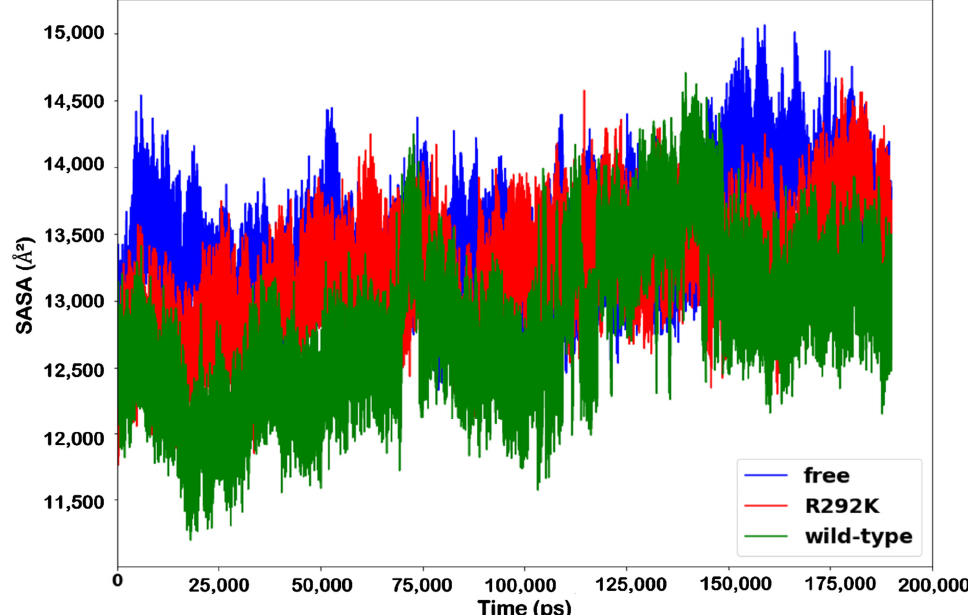
Figure 8. SASA (Å 2 ) plot of peramivir-free neuraminidase and the peramivir-wild-type and peramivir- R292K neuraminidase complexes over the simulation time (ps).